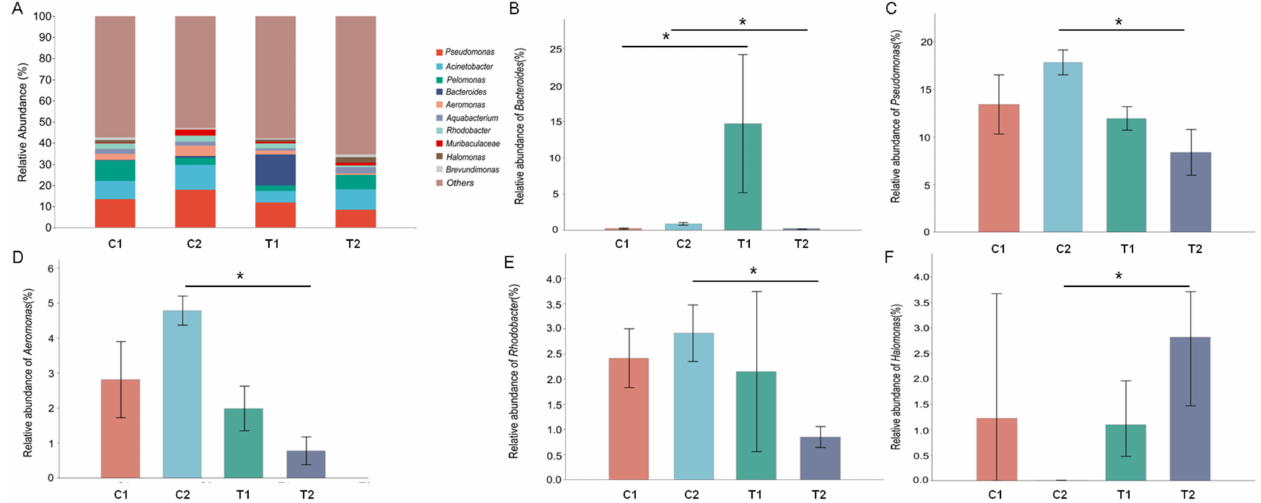
Figure 4. Composition of Cipangopaludina cathayensis intestinal microflora at the genus level. ( A ) Com- position of the intestinal microflora among treatment groups C1 (control treatment; 25 ± 1 ◦ C, day 3), C2 (control treatment; 25 ± 1 ◦ C, day 7), T1 (high-temperature treatment; 32 ± 1 ◦ C, day 3), and T2 (high-temperature treatment; 32 ± 1 ◦ C, day 7); ( B ) relative abundance of the genus Bacteroides ; ( C ) relative abundance of the genus Pseudomonas ; ( D ) relative abundance of the genus Aeromonas ; ( E ) relative abundance of the genus Rhodobacter ; ( F ) relative abundance of the genus Halomonas . Asterisks indicate p -values <